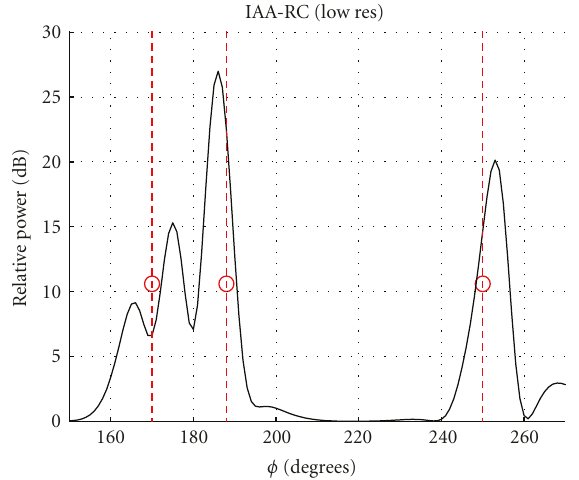
Figure 8: IAA-RC (low-res) spatial estimate (one realization, rectangular array, θ 1 = 45 ◦ , φ 1 = 170 ◦ , θ 2 = 45 ◦ , φ 2 = 188 ◦ , θ 3 = 45 ◦ , φ 3 = 250 ◦ , N = 3 snapshots, SNR 1 = SNR 2 = SNR 3 = 10dB, noise power equal to 0dB, and f c = 1575MHz).